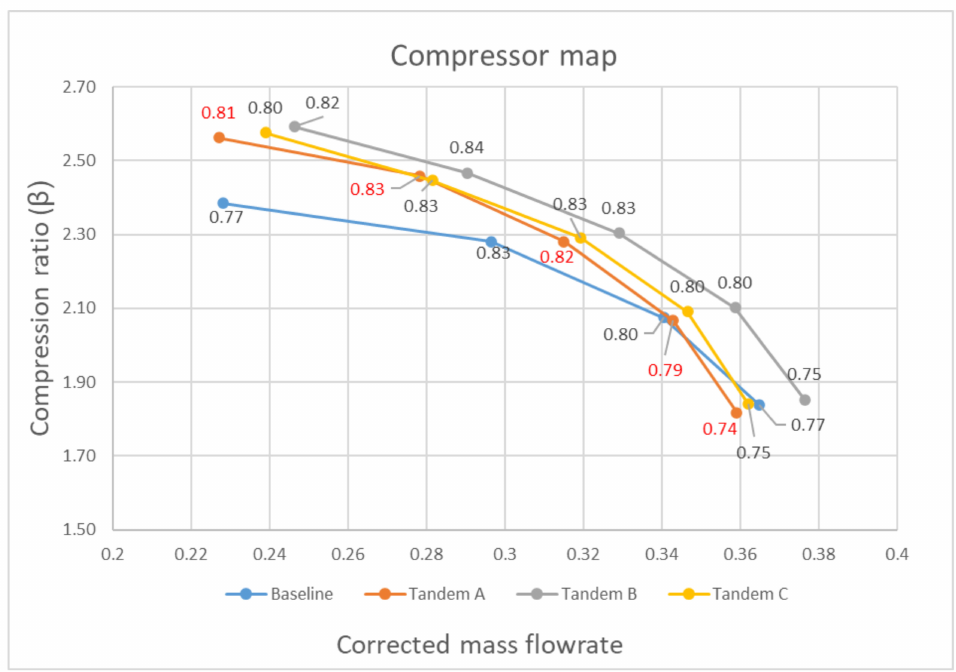
Figure 13. Characteristic curves for the conventional and tandem compressor. The relative Ma plots of Figure 14 show that the Tandem A rotor has substantially lower sonic losses at the intake, while at rotor exit the Ma profiles are similar. Both plots choking is visible in the circled regions, where the local Ma is near or even in excess of one.